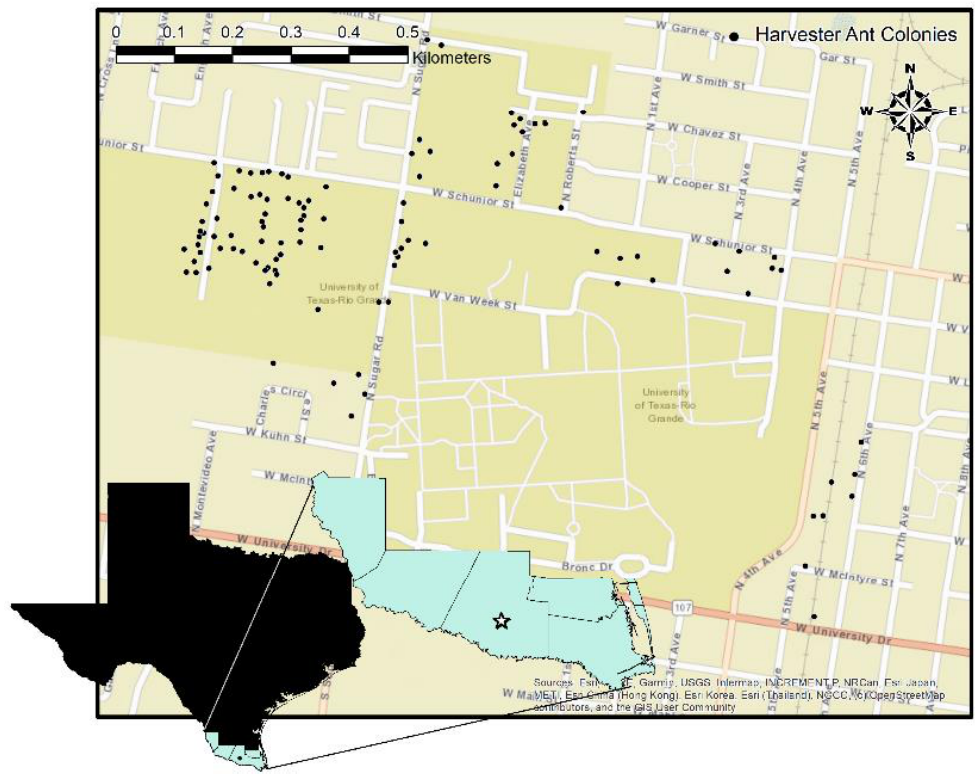
Figure 1. Map of Pogonomyrmex barbatus F. Smith (Hymenoptera: Formicidae: Myrmicinae) nest sites (represented by black dots) within the study area located in Edinburg, TX, USA (yellow star).